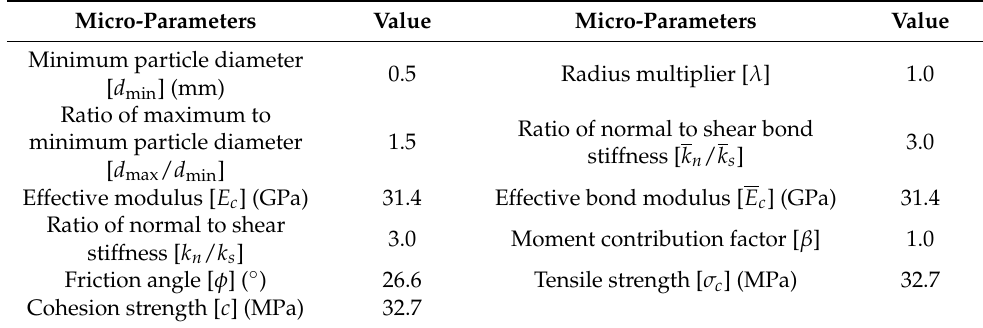
Table 2. Micro-parameters determined for the parallel bond model.